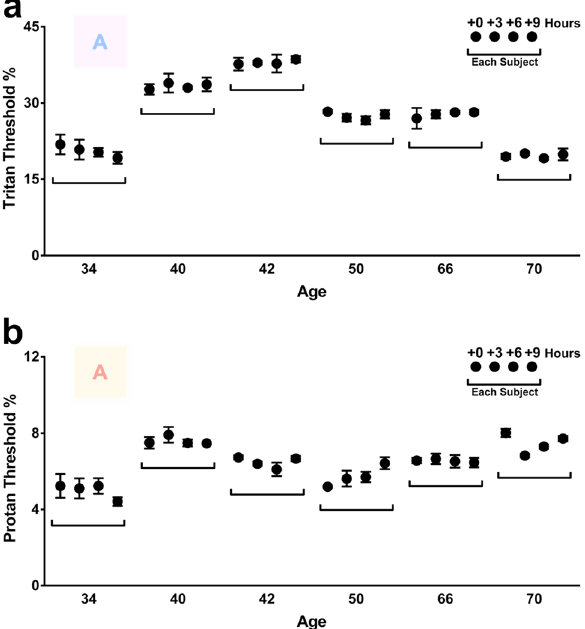
Figure 4. Variation in colour contrast sensitivities (CCS) across the day in 6 subjects. CCS of tritan ( a ) and protan ( b ) axes measured in 6 subjects (34–70 years) in 3 h intervals across the day. The four black closed circles within the bar represent each subject, measurements were taken in 3 h intervals at 8AM, 11AM, 2PM and 5PM. The colour letter A in both graphs is an example of the target to be identified as it appeared on the screen. Thresholds for tritan function revealed no significant variation across the day when measured in a 34 (p = 0.6898), 40 (p = 0.8902), 42 (p = 0.9388), 50 (p = 0.3890), 66 (p = 0.8592), and 70 (p = 0.7613) year-old. Similarly, thresholds for protan function revealed no significant variation across the day when measured in a 34 (p = 0.5802), 40 (p = 0.6149), 42 (p = 0.1937), 50 (p = 0.0943), 66 (0.9588), and 70 (p = 0.2222) year-old.